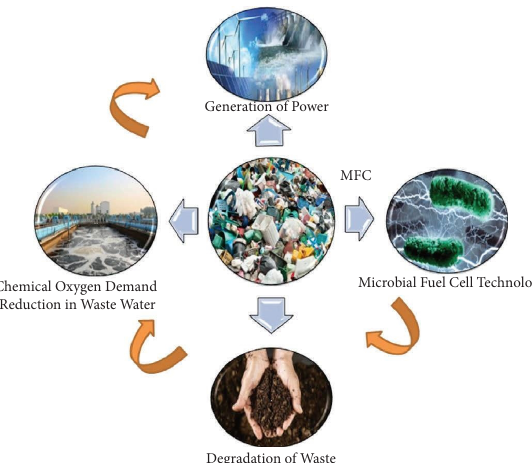
Figure 1: Generation of power from organic